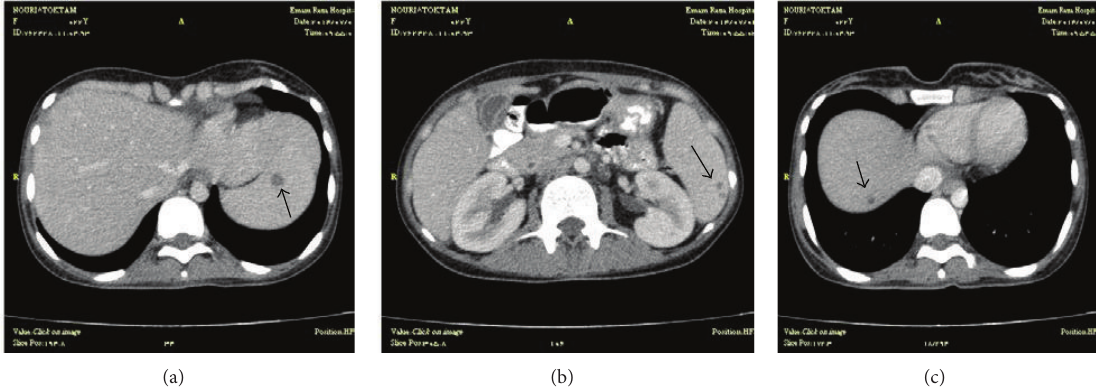
Figure 2: Computed tomography of the abdomen and pelvis with intravenous and oral contrast reveals multiple hypodense lesions in spleen ((a) and (b)) and liver